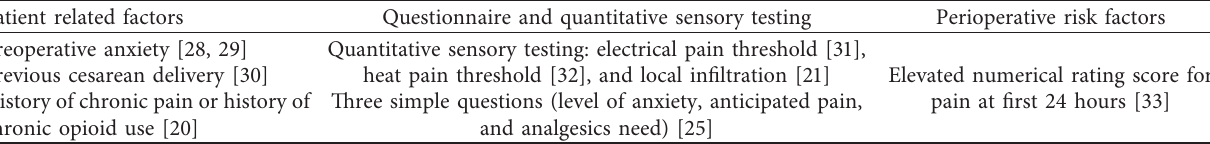
Table 1: Risk factors for severe postoperative pain after cesarean